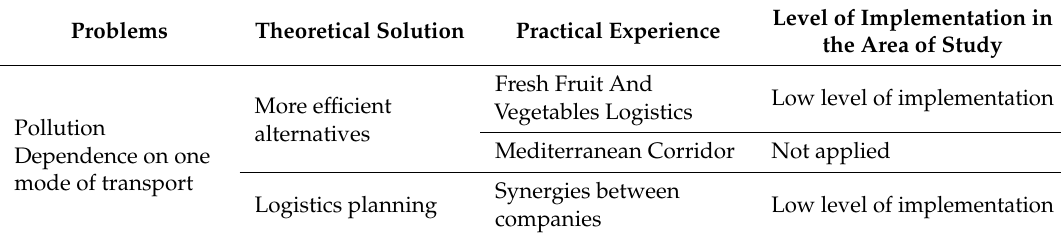
Table 12. Principal solutions based on the CE for transport from the handling center to the